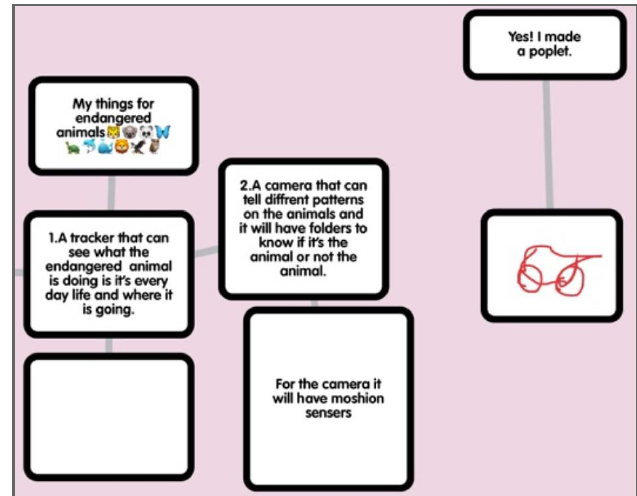
Figure 4. Emily’s passion project